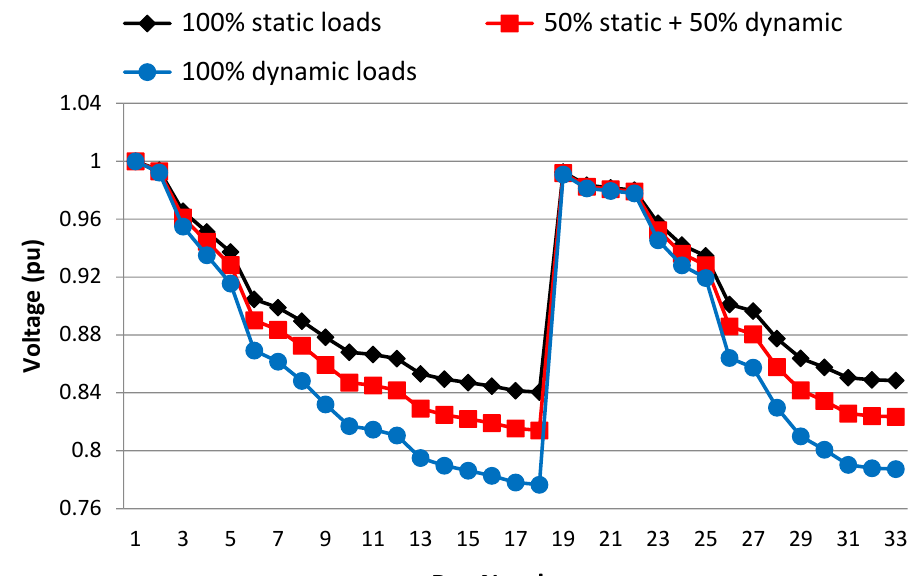
Figure 7. Effect of load type on voltage profile at 200% loading. In the last loading condition of 250%, the 100% static loading shows better perfor- mance than the other cases. The minimum voltage is reduced to 0.808 pu and the losses reach up to 824.7 kW and 543.7 kVAr, as seen in Table 4. The worst case was the 100% dynamic load, where the minimum bus voltage is 0.704 pu and the losses are up to 1889.3 kW and 1263.2 kVAr. The bus voltage profile for the 250% loading condition is shown in Figure 8. Table 4. Comparison between static and dynamic loads at 250% loading, i.e., a total load of (8950 + j4362) kVA.